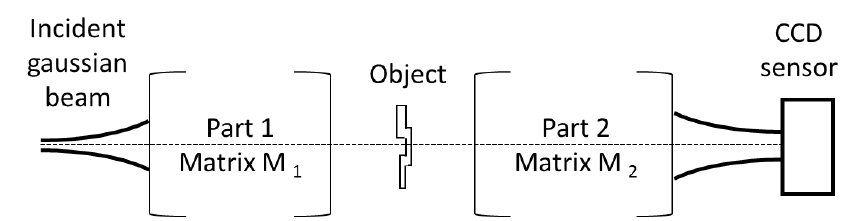
Figure 1. Typical Digital In-Line Holography